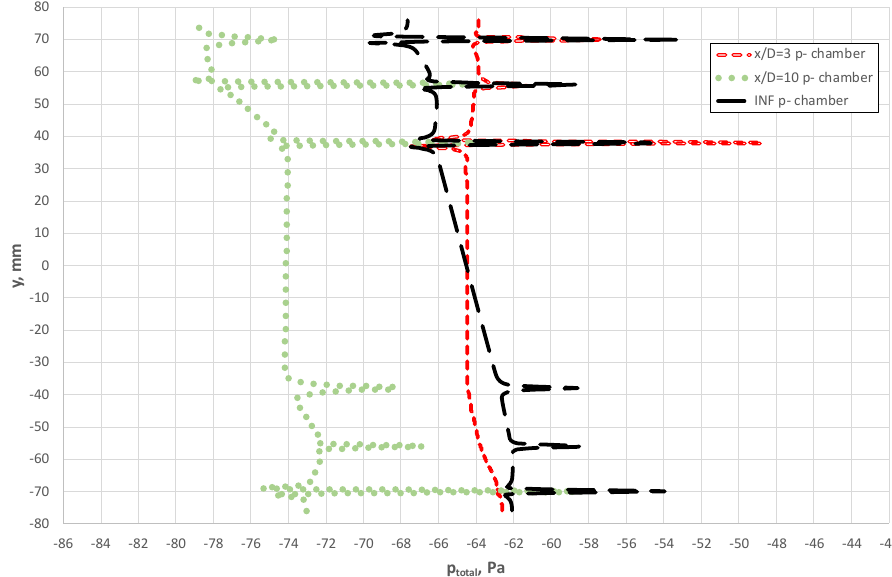
Figure 17. Total pressure along the axis of the p − chamber at various distances between the probe and the elbow.